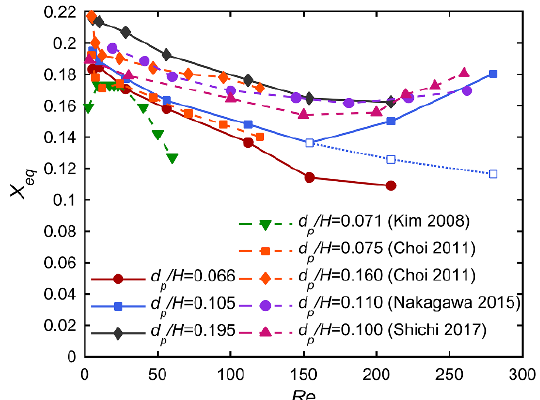
Figure 5. Particle equilibrium position Xeq (distance between the particle center and the nearest channel wall) for different particle to channel size ratios with respect to Re . Solid lines correspond to the face-centered equilibrium positions, while the dashed lines indicate the newly-arisen equilibrium positions near the channel corners.